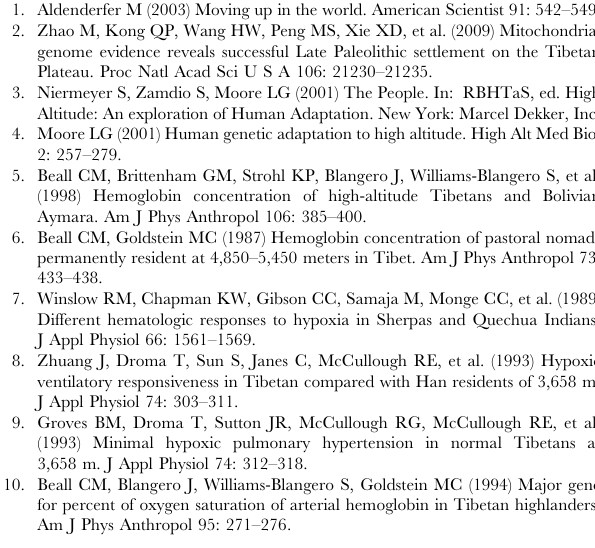
Table S5 Significant biallelic CNP LSBLs (p , 0.01) in Andeans and Tibetans. DOC) Table S6 Significant Andean CNP REHHs. Tibetans did not display any significant CNP REHHs. DOC) Table S7 CNVs overlapping with extended haplotype homozy- gosity regions identified by the WGLRH test. DOC) Table S8 Populations assayed using the Affymetrix Inc. (Santa Clara, CA) Genome-Wide Human SNP Array